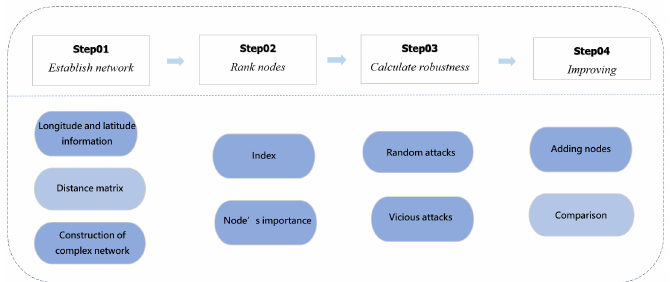
Figure 1. The robustness evaluation